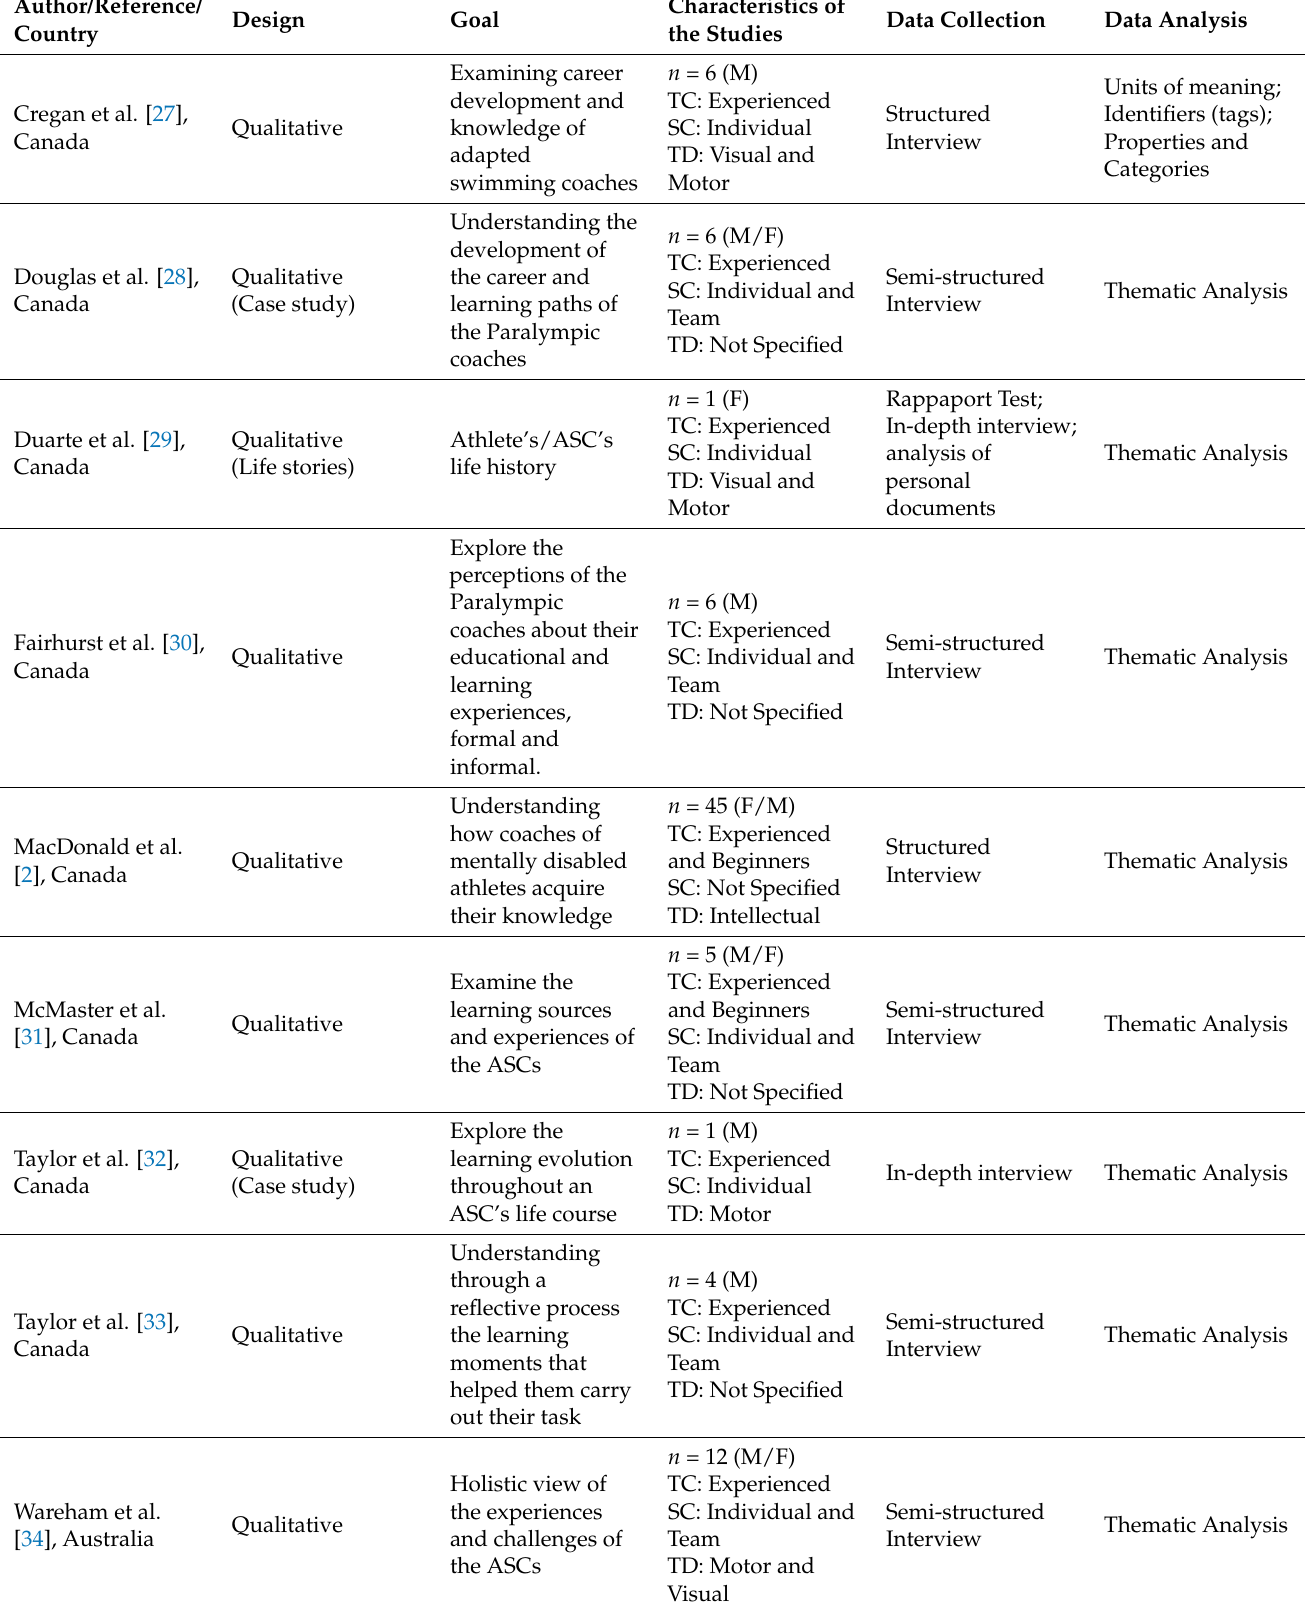
Table 2. Description of the characteristics of the included